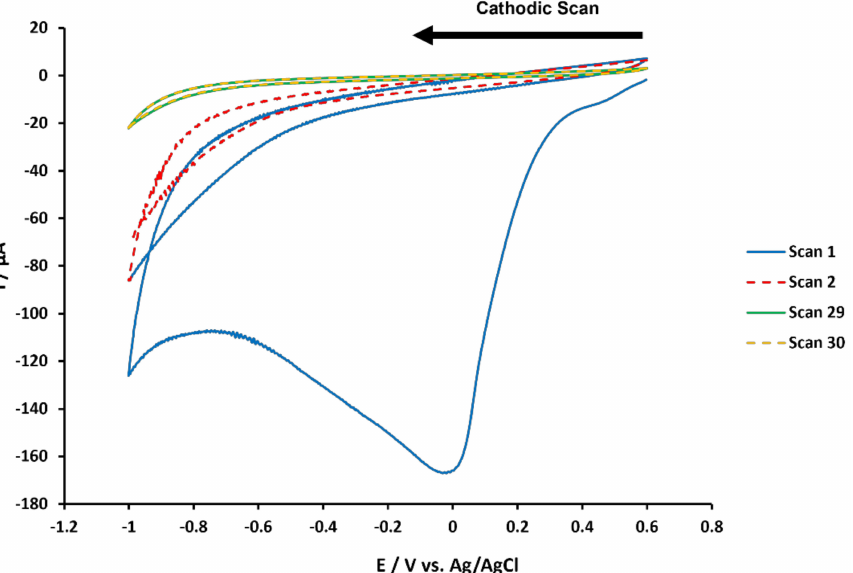
Figure 1. CV of 2 mM DDAN in acetonitrile along with 10 mM of tetrabutylammonium tetrafluorob- orate at a scan rate of 0.05 V s − 1 between +0.6 V and _ 0.9 V vs. Ag/AgCl: scans 1, 2, 29 and 30 (the last scan) are